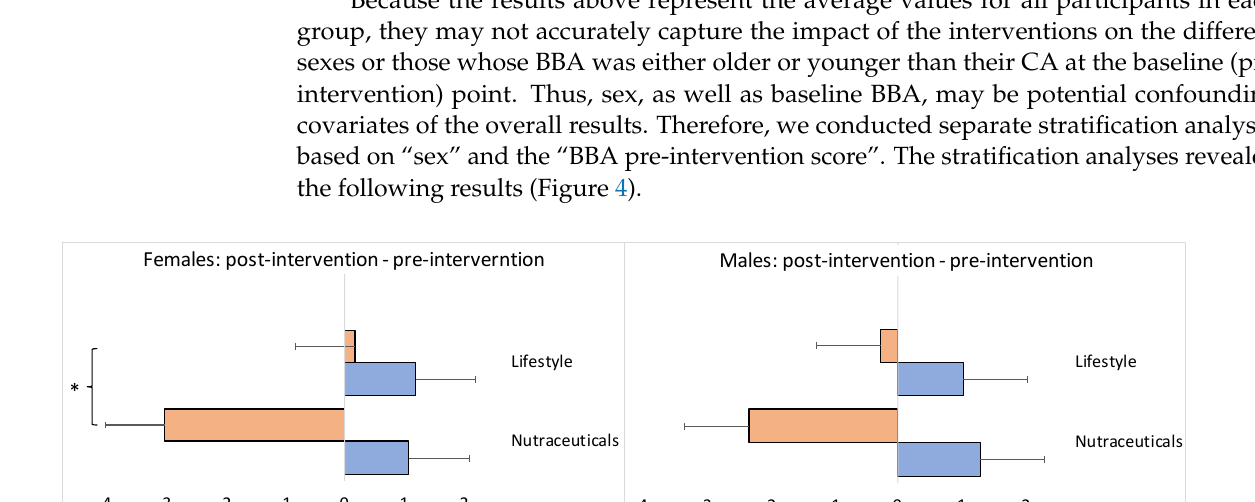
Figure 5. Difference between the post- and pre- intervention endpoints as a function of the interven- tion (i.e., nutraceutical supplementation versus lifestyle changes) separately for situations when the pre- intervention BBA was older or younger than the CA. The x - axis represents the differ ence in years. CA: chronological age; BBA: biological brain age. The asterisks denote p < 0.01 (**). The bars